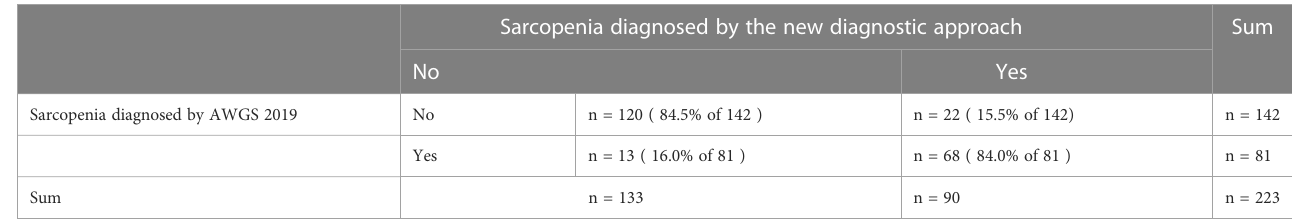
TABLE 4 In a statistical measure of agreement between the AWGS 2019 and the new diagnostic approach for all participants. Sarcopenia diagnosed by the new diagnostic